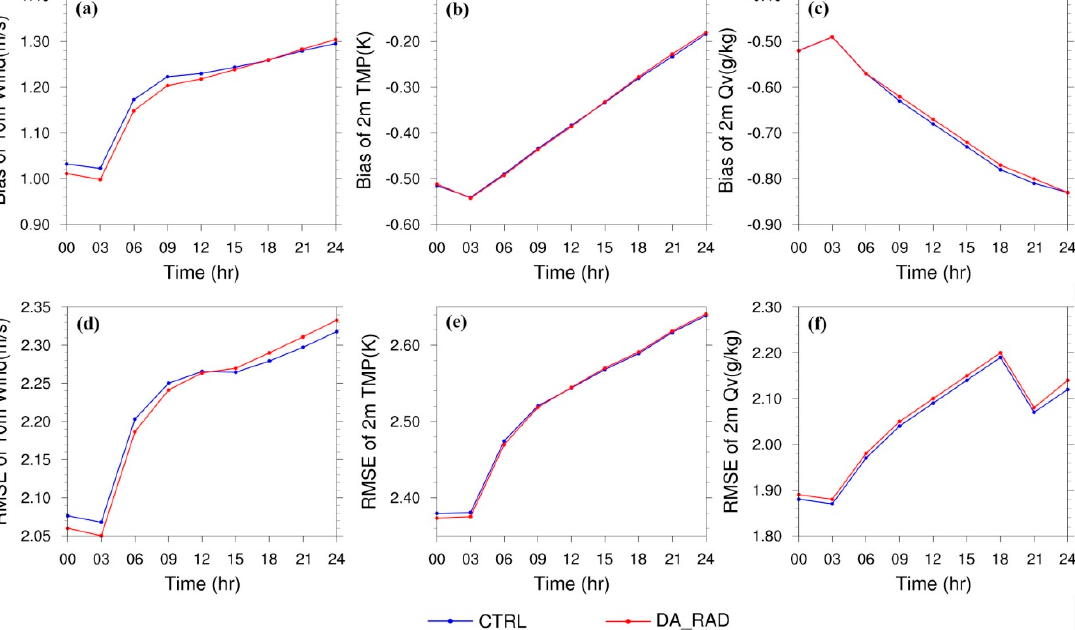
Figure 10. Time series of the 3-h average bias and RMSE for ( a , d ) wind at 10 m and ( b , e ) temperature (TMP) and ( c , f ) humidity (Qv: water vapor mixing ratio) at 2 m for retrospective run forecasts over the period of 1–12 August